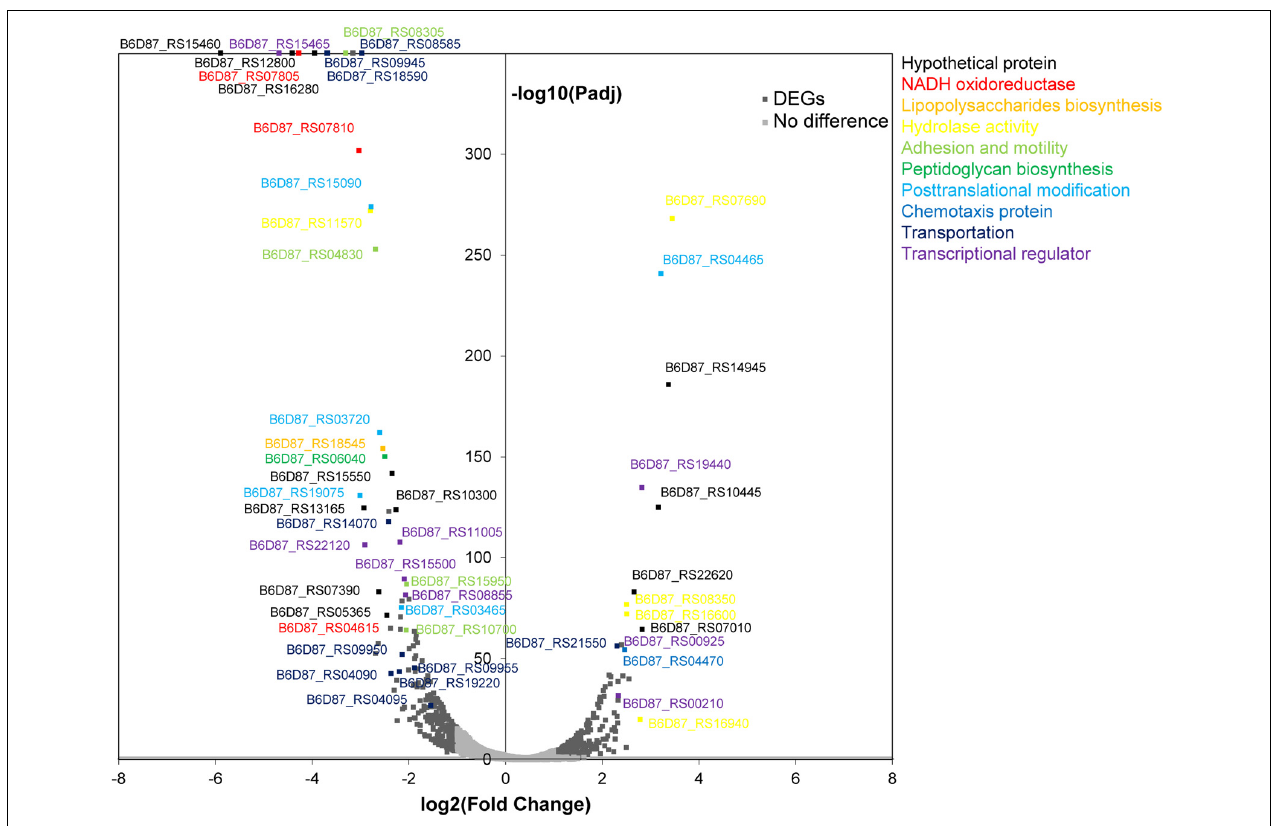
FIGURE 1 | Volcano plot of genes expressed differentially between MAP and air samples. P adj , adjusted p -value. The P adj of the DEGs at the top is 0 (all data corresponding to DEGs under these two conditions can be found in Supplementary Table